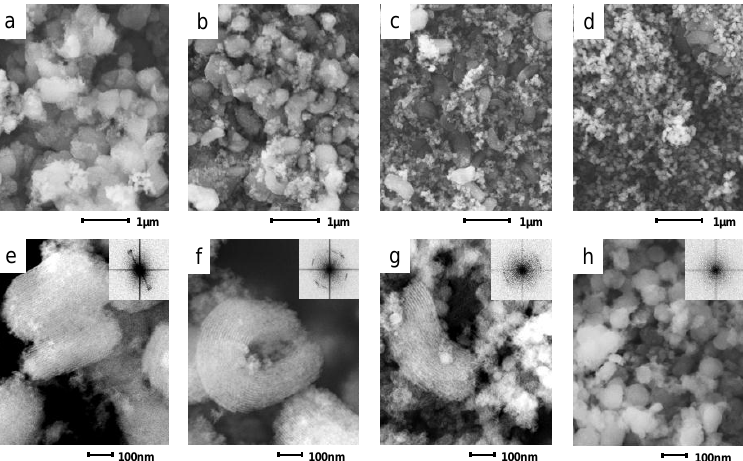
Figure 3. Scanning electron microscopy (SEM) images of nano ZSM-5/SBA-15 analog (ZSC) composites with various precrystallization times of either 6, 12, 24 or 36 h (from left to right): ( a – d ) SEM images with 20× magnification shown in upper row; ( e – h ) 100× images in lower row; ( e , f , g ) Insets show FFT (Fast Fourier Transformation) images of the respective SEM to illustrate presence or ( h ) absence of periodically ordered mesoporosity [41]. This figure was published in J. Mater. Sci., Direct synthesis of nanosized-ZSM-5/SBA-15 analog composites from preformed ZSM-5 precursors for improved catalytic performance as cracking catalyst, 49, 2014, 5676–5689, Vu, X.H.; Bentrup, U.; Hunger, M.; Kraehnert, R.; Armbruster, U.; Martin, A. Reproduced with permission of